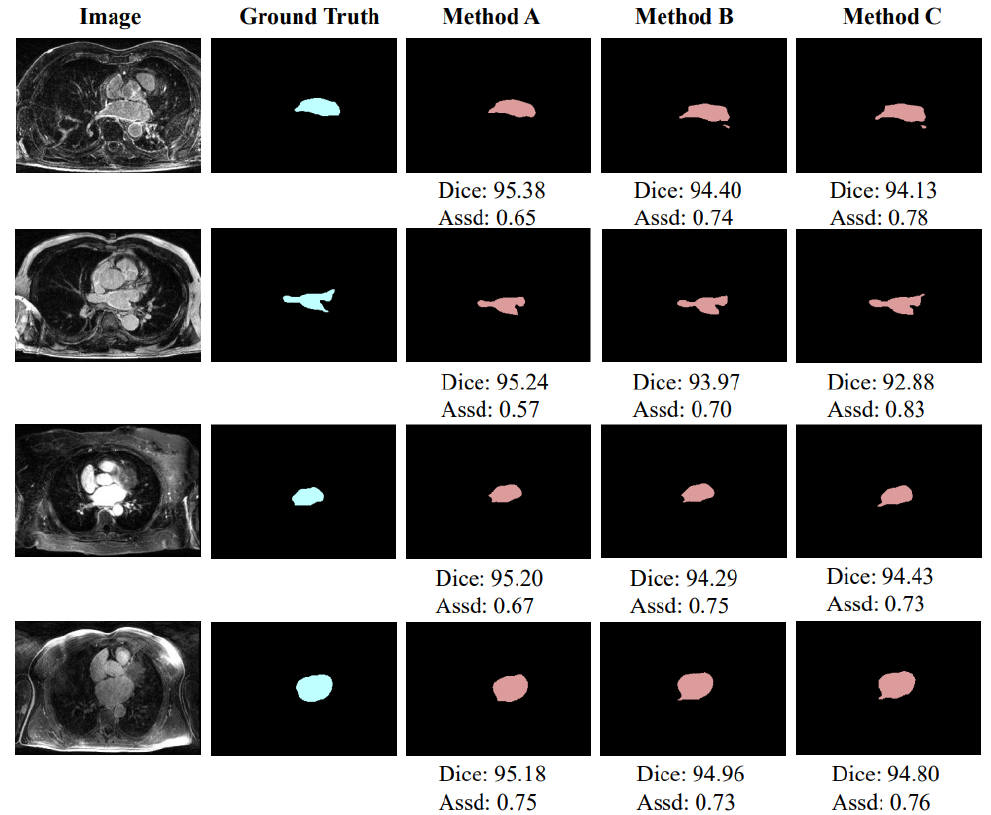
Figure 5. Exemplar segmentation results using different methods to generate distance maps.